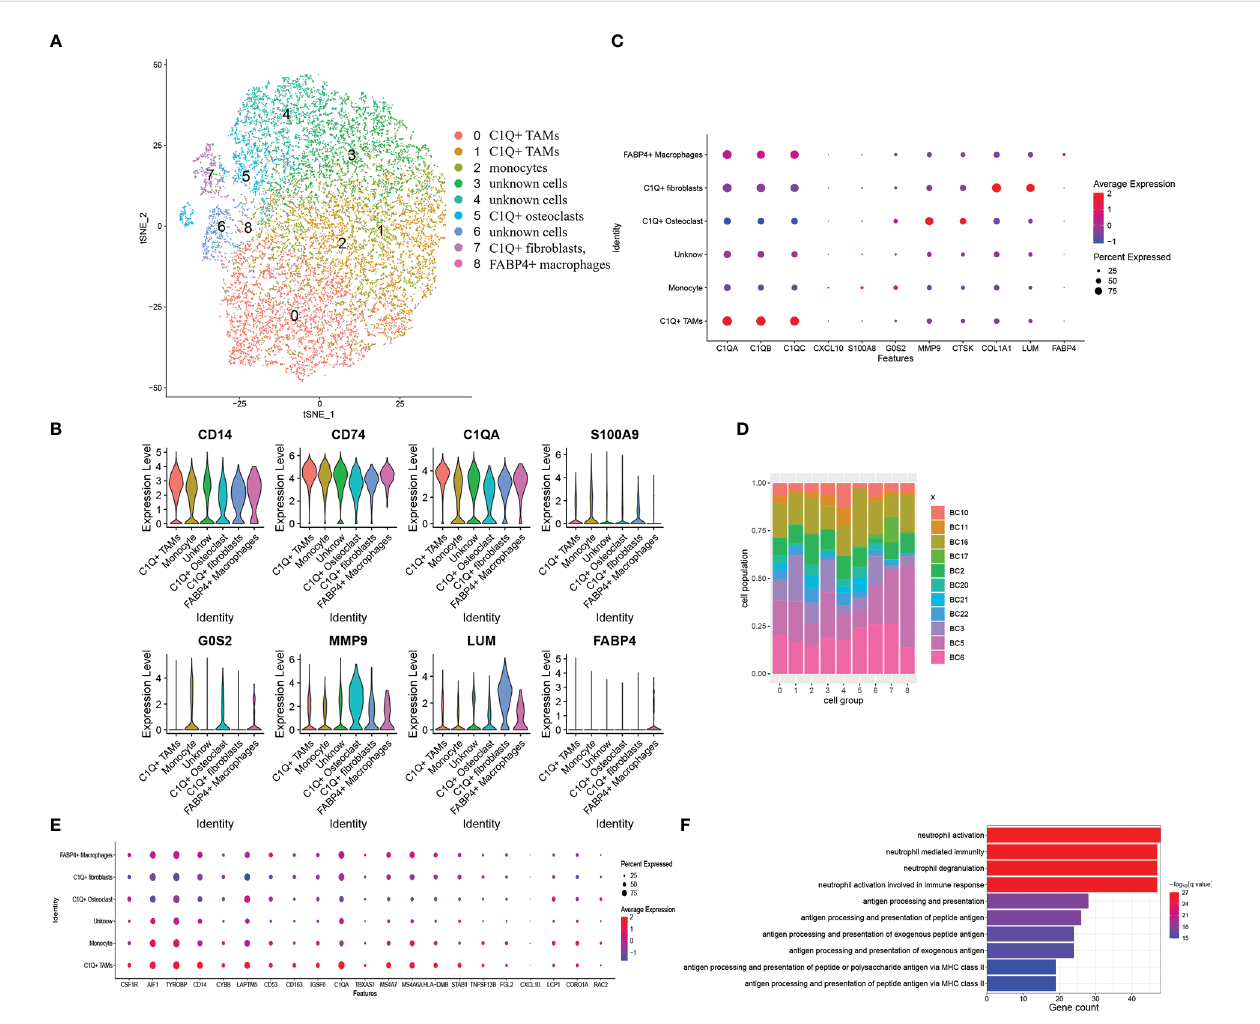
FIGURE 4 Myeloid cells subclustered and DEGs combined with these six cell groups. (A) The t-SNE plot of the nine identi fi ed clusters or six cell groups. (B) Violin plots showed the normalized expression levels of representative markers across the six cell groups (C) Representative markers expression in six cell groups. Dot size and color delivered the same meaning as the previous dot plot (D) Distribution of the nine clusters among 11 patients with OS. (E) Dot plot of the overlapped DEGs, which represented as C1Q+ TAM markers. The plot showed expressing proportion and level among six cell groups of these DEGs. (F) Biological process enrichment of C1Q + TAM